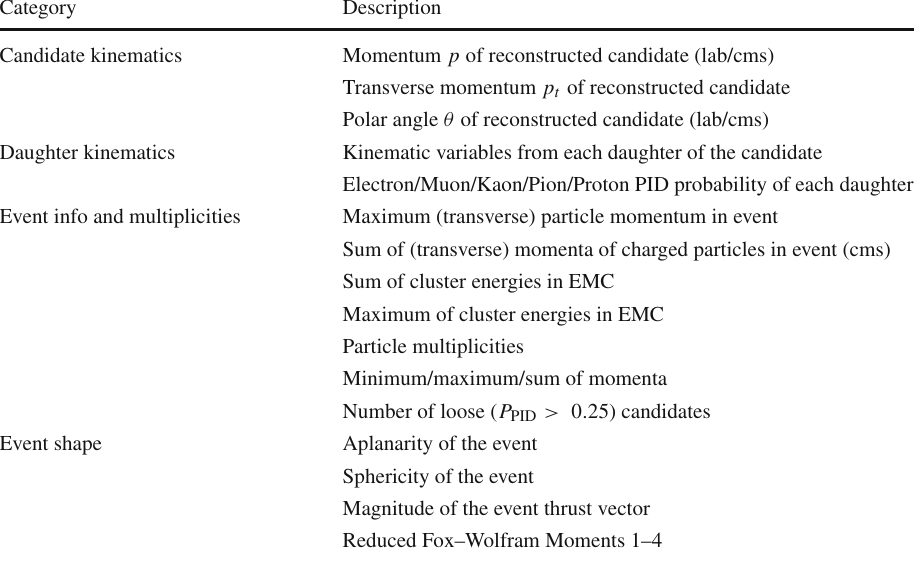
Table 2 Summarised list of the standard input observables as well as additional event shape input observables.